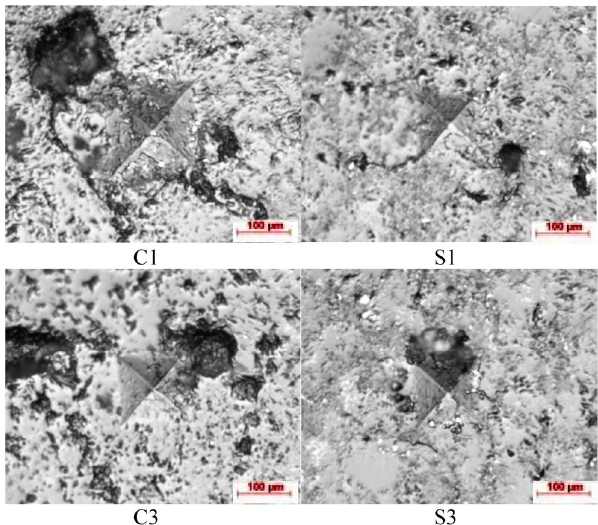
Fig. 5 Optical image of Vickers indentation taken at cross section of the chromia coatings.